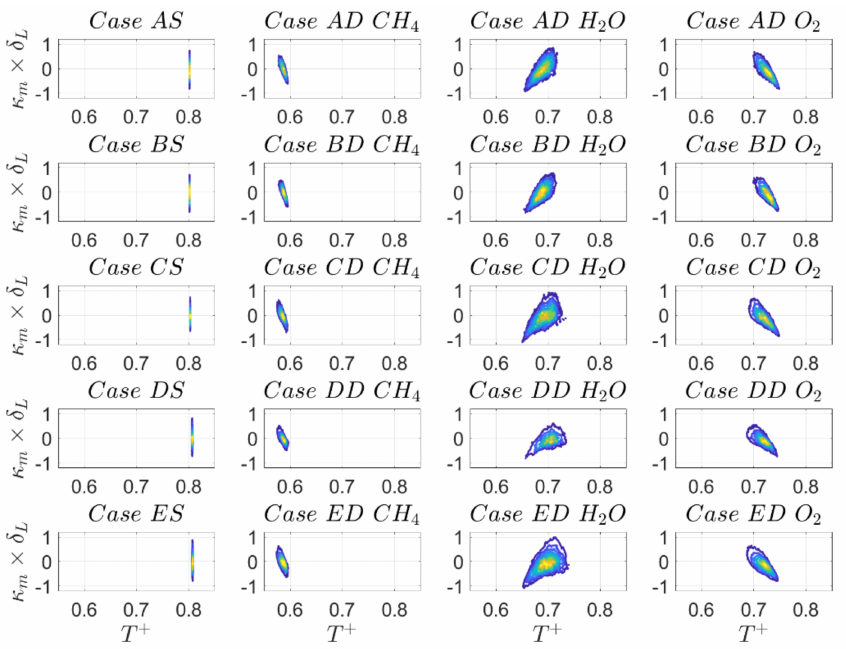
Figure 19. Joint PDF of non-dimensional temperature and normalised mean curvature κ m × δ L on c = 0.8 progress-variable isosurface for top to bottom cases A–E for (1st column) SC and (2nd to 4th column) DC simulations for reaction progress variable based on CH 4 , H 2 O,O 2 mass